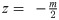
Distance-decay relationships of community similarity for epilithic biofilms.Data represent log-log regressions of Sørensen similarity index values calculated from OTUs abundances versus geographic (upper panel) and environmental (lower panel) distances for within floodplains (open dots) and among floodplains (filled dots). Both slopes (m) were significantly different from zero, p-value <0.01. Scaling coefficient (z) for the geographic distance-decay was derived from the plot as z= −m2 following Harte et al. [41].